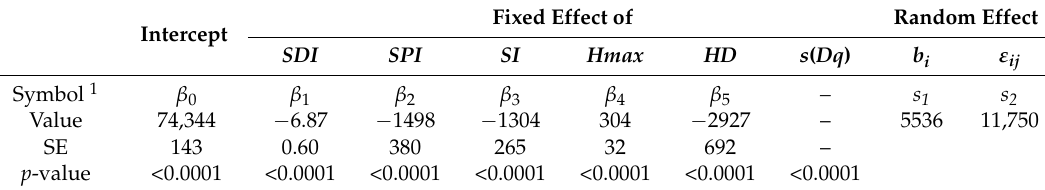
Table 4. Coefficients of the regeneration biomass model based on the NFI (German National Forest Inventory, Equations (4a) and (5)). The variables are denoted as in Equations (4a) and (5), i.e., SDI (Stand Density Index), SPI (Species Profile Index), SI (Site Index), Hmax (maximum height), HD (Height Diameter Characteristic), Dq (Quadratic Mean Diameter); β 1 to β 5 are corresponding fixed effect coefficients; s ( Dq ) is a univariate penalized cubic regression spline [31] over Dq (Figure 1a); b is the NFI cluster specific random effect, and s 1 is its standard deviation; ε represents the i.i.d. errors and s 2 represents their standard deviation.